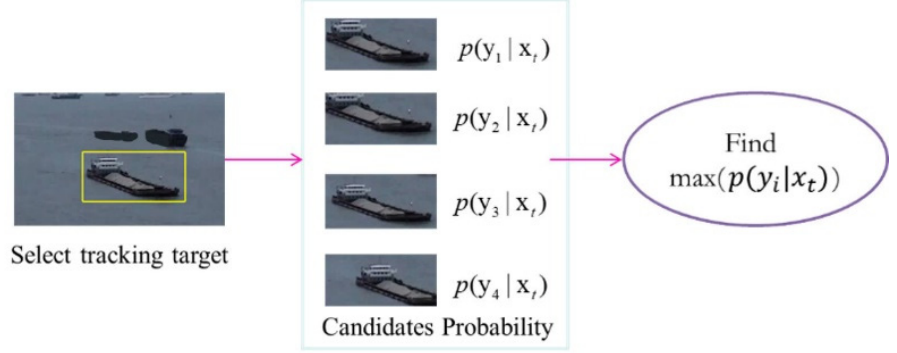
Figure 11. Flow chart target selection. (8) Output box to calculate the target identification error.